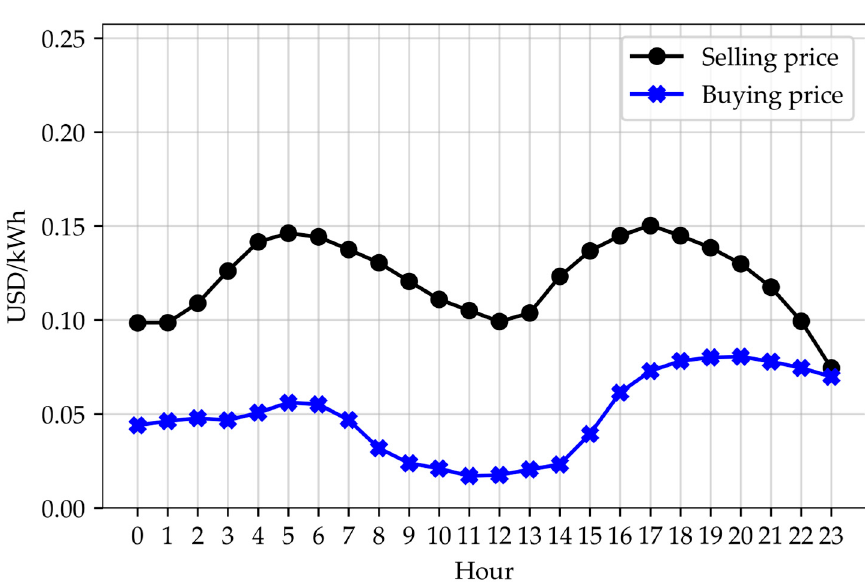
Figure 8. The hourly mean energy prices of Case II.